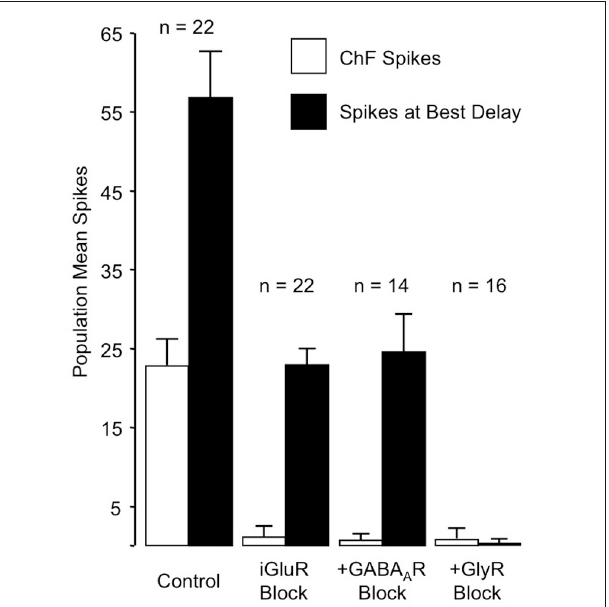
FIGURE 11 | Primary role of GlyR receptors in the facilitated response of IC neurons. Graphs show number of spikes evoked by ChF and combination stimuli at best delay, averaged across the number of neurons in the sample. iGluR blockade eliminates spikes evoked by ChF tones, but does not eliminate facilitated spikes evoked by combination stimuli. The addition of GABA A R blockade to the iGluR blockade ( + GABA A R Block) has little additional effect on the facilitated spikes. Facilitation spikes are only eliminated by addition of the GlyR blockade ( + GlyR Block). Neither + GABA A R Block nor + GlyR Block revealed additional excitatory response to the ChF response, suggesting that iGluR blockade successfully eliminated glutamatergic excitation to the neurons. Adapted from Sanchez et al. (2008), with